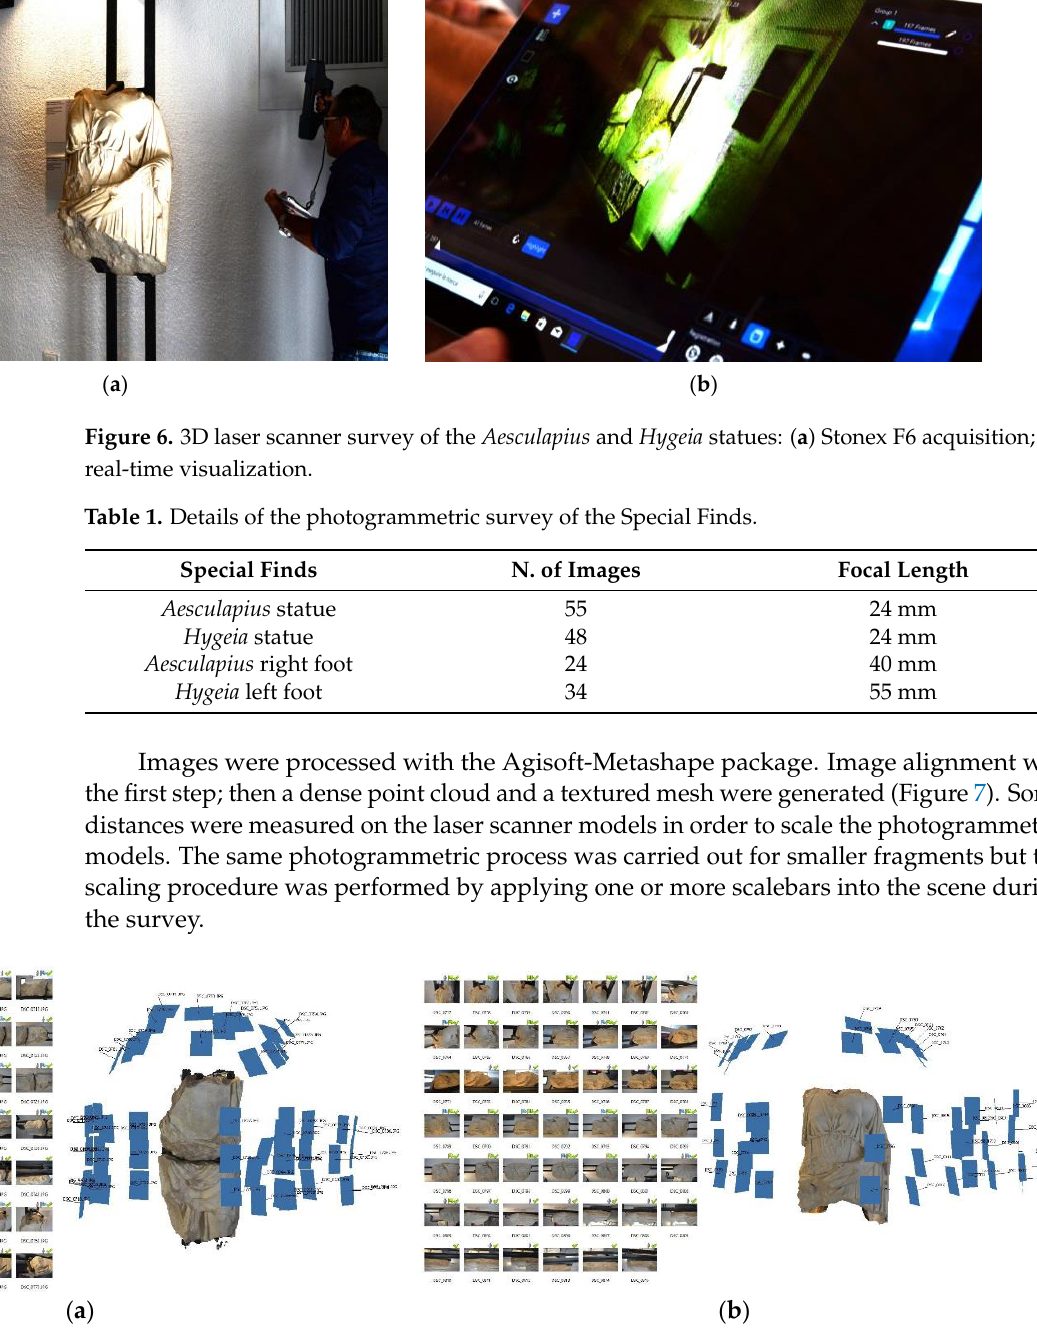
Figure 7. Agisoft-Metashape photo alignment step of the Aesculapius ( a ) and Hygeia statues ( b ).